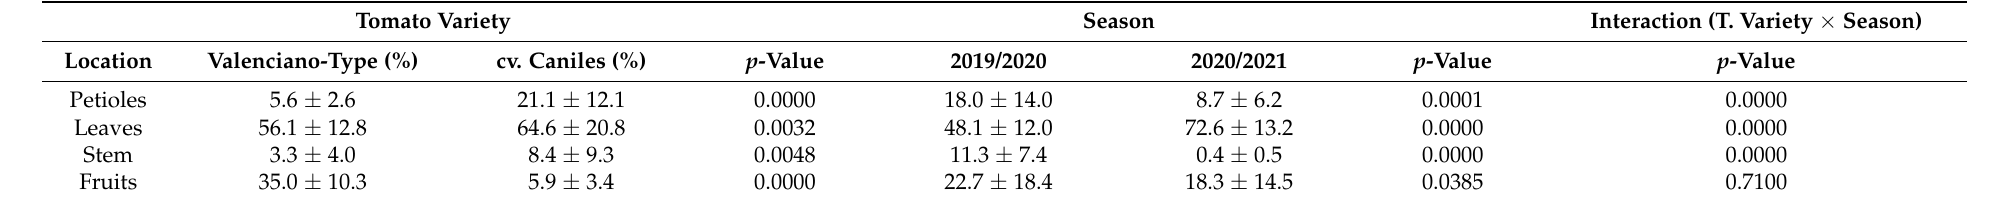
Table 4. Effect of tomato variety and season on the incidence of grey mould linked to the location of the infection site. Tomato